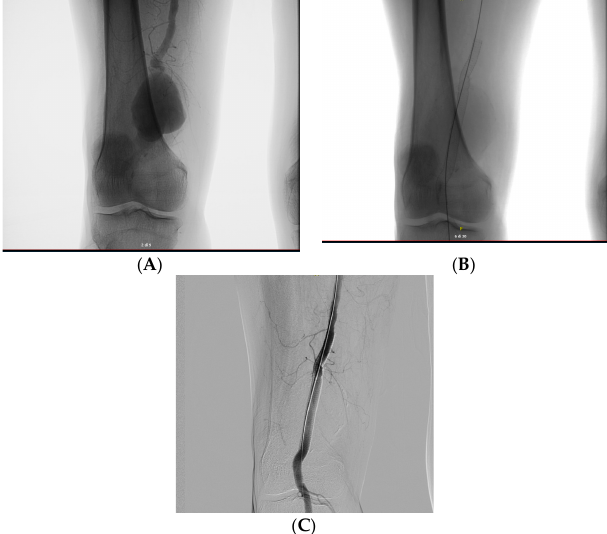
Figure A1. Angiogram of pre- ( A ), during ( C ) and post- ( B ) endovascular treatment.